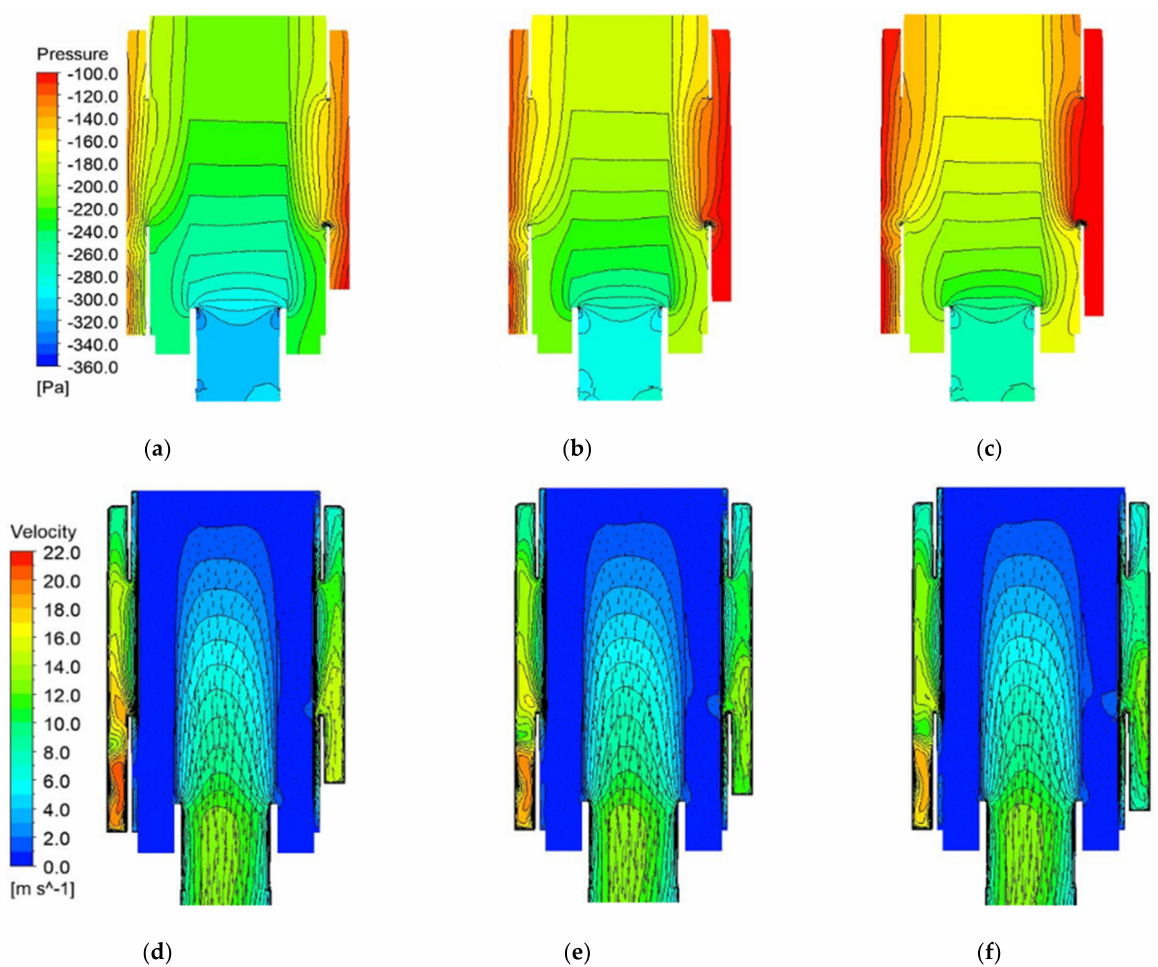
Figure 14. Pressure and velocity contour on plan specified Figure 12 according to change in design variable α at 6000 rpm condition: pressure contours at ( a ) α = 30 ◦ , ( b ) α = 40 ◦ and ( c ) α = 50 ◦ , and velocity contours at ( d ) α = 30 ◦ , ( e ) α = 40 ◦ and ( f ) α = 50 ◦